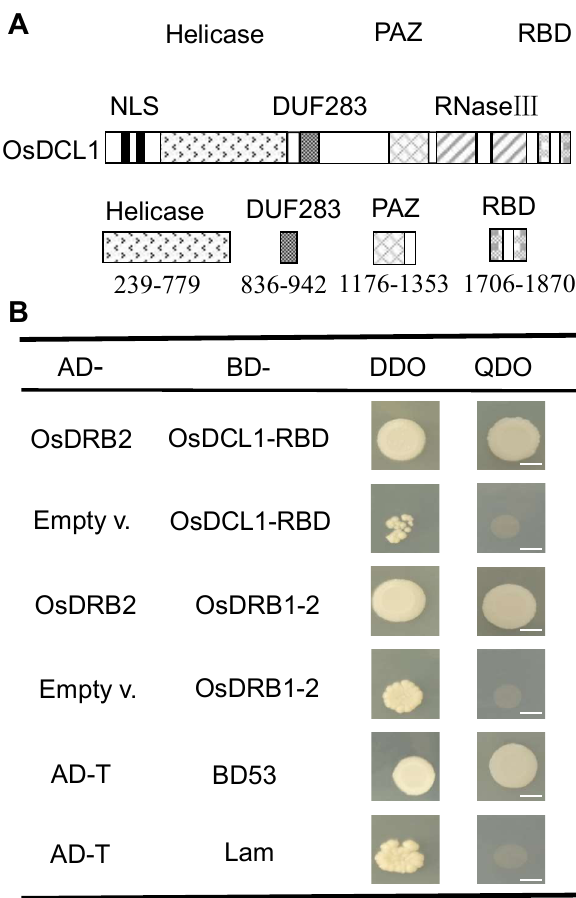
Figure 7. Interaction of OsDRB2 with OsDCL1-RBD and OsDRB1-2. ( A ) The structure diagram of DCL1 protein. Abbreviations of domains are as follows: NLS: nuclear localization signal; Helicase: DExD/H-box RNA helicase; DUF283: domain of unknown function 283; PAZ: Piwi/Argonaute/Zwille domain; RNase III: ribonuclease III; RBD: dsRNA-binding domains. ( B ) Yeast two-hybrid experiments showed the interactions of OsDRB2 with OsDCL1-RBD and OsDRB1-2 respectively. Interaction between pGADT7-T (AD-T) and pGBKT7-53 (BD53) was used as a positive control, and interaction between pGADT7-T (AD-T) and pGBKT7-Lam (Lam) was used as a negative control. Co-transformed yeast colonies were spotted on DDO ( − Leu/ − Trp) non-selective medium and QDO ( − Leu/ − Trp/ − His/ − Ade) selective medium, respectively. White bars indicate 5